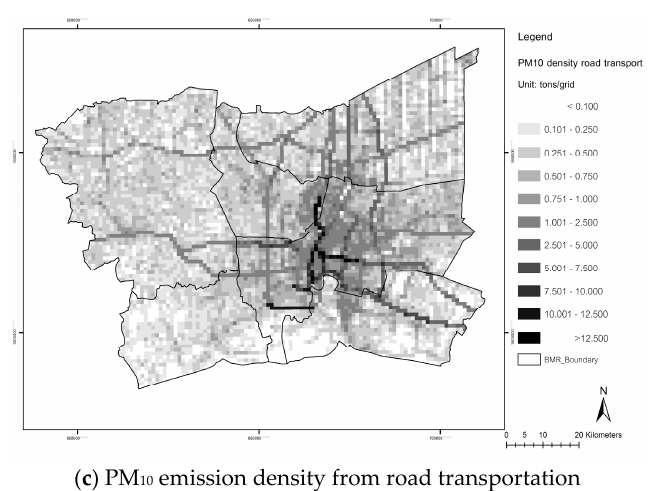
Figure 16. Spatial allocation of PM 10 emission in the BMR, 2015: ( a ) light duty vehicles and motorcycles; ( b ) heavy duty vehicles; ( c ) road transportation.